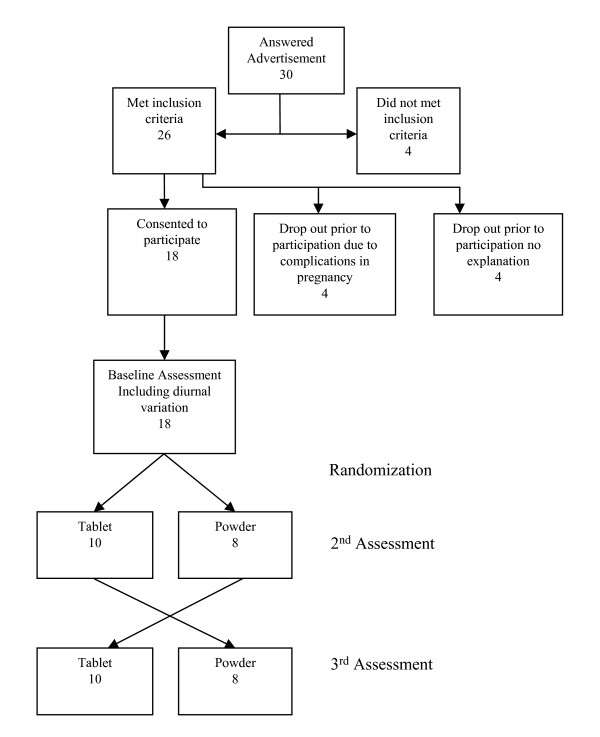
Study Flow Diagram.